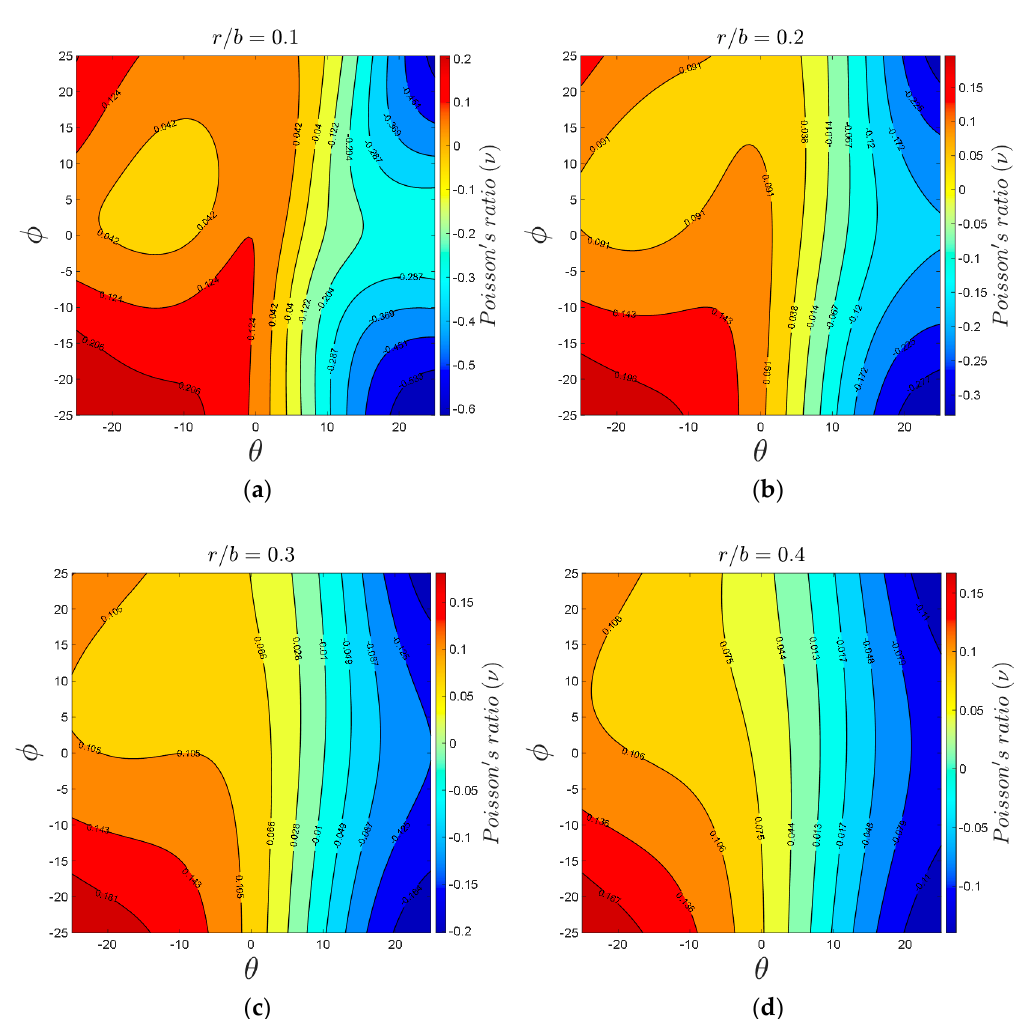
Figure 13. Variations of Poisson’s ratio with respect to θ and ϕ : ( a ) r / b = 0.1, ( b ) r / b = 0.2, ( c ) r / b = 0.3, and ( d ) r / b = 0.4 .